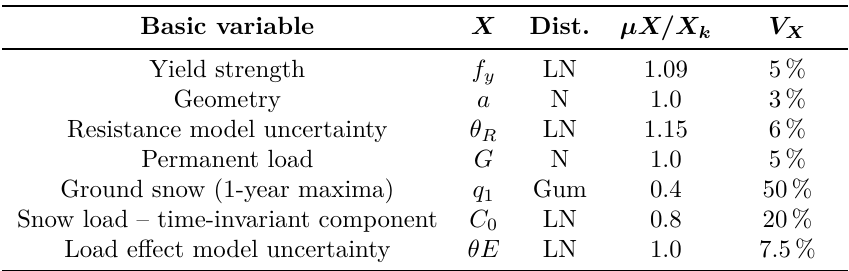
Table 1. Probabilistic models of basic variables considered in the case